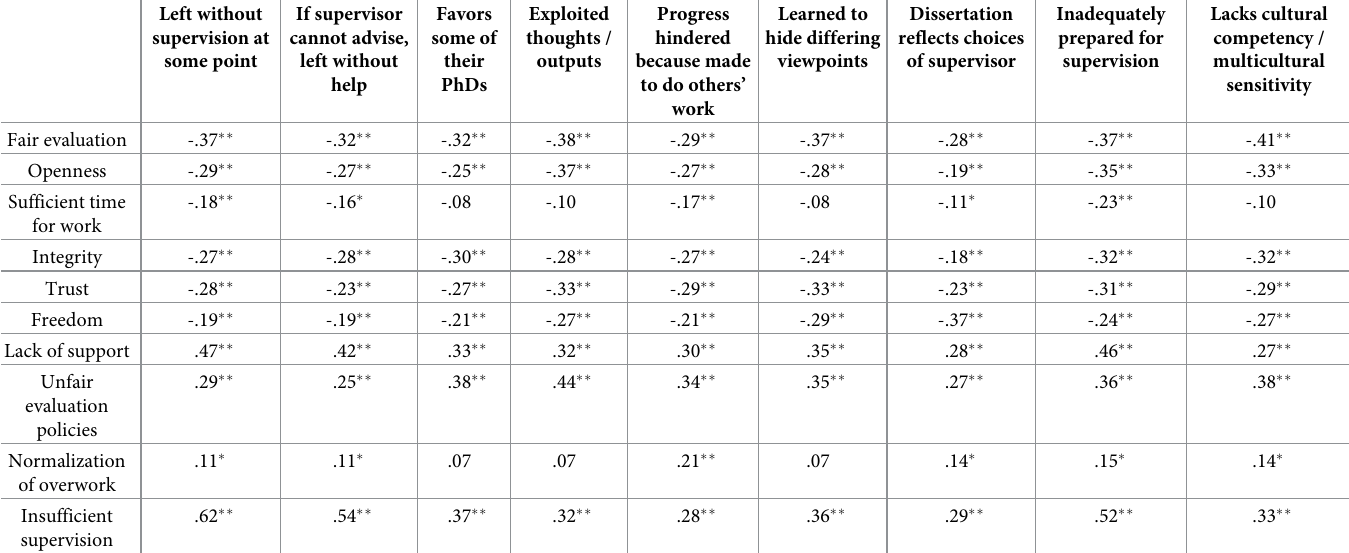
Table 3. Spearman correlations for research climate items and supervisory practices (A).